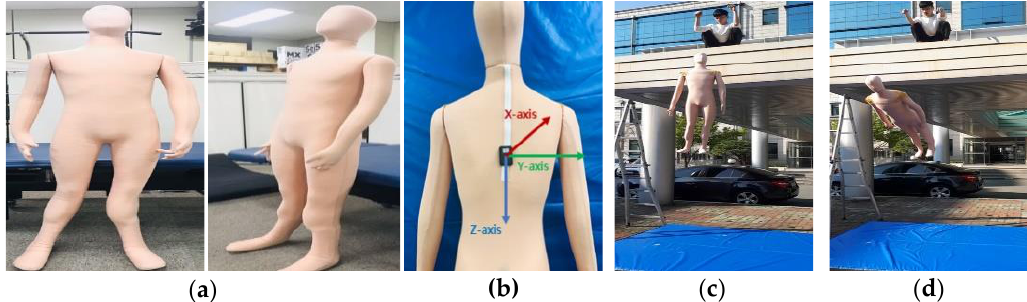
Figure 3. ( a )Mannequinusedintheexperiments, ( b )sensorposition, ( c )verticalFFH,and( d Figure 3. ( a ) Mannequin used in the experiments, ( b ) sensor position, ( c ) vertical FFH, and ( d ) forward FFH.